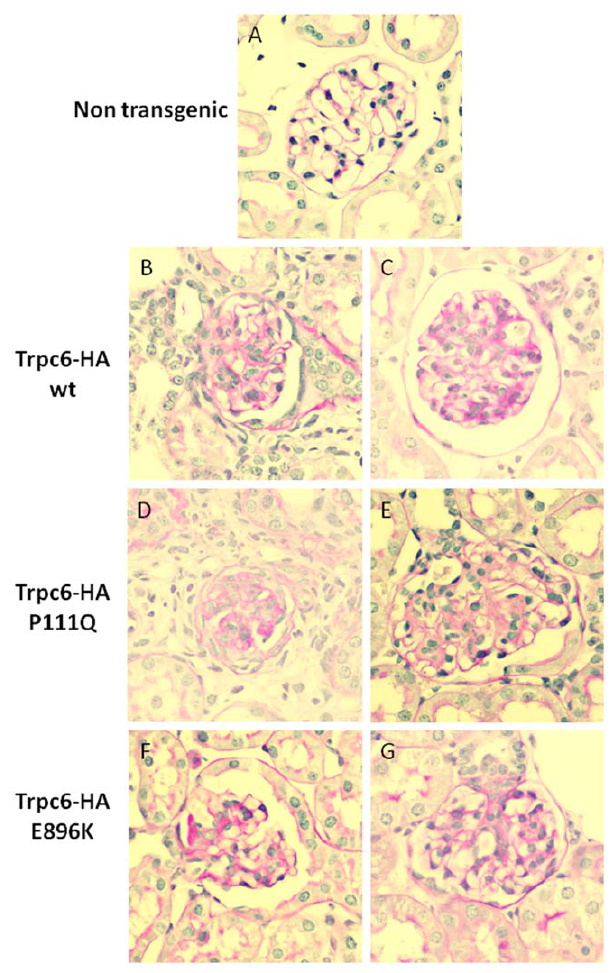
Figure 5. Histopathological lesions analyzed in adult trans- genic mice. Representative examples of kidney sections stained with PAS in 400x for all the samples are shown. (A) Non transgenic mouse normal glomerulus, (B) Trpc6-HA wt line 419, (C) Trpc6-HA wt line 421, (D) Trpc6-HA P111Q line 615, (E) Trpc6-HA P111Q line 616, (F) Trpc6-HA E896K line 73a and (G) Trpc6-HA E896K line 75a. The glomerular lesions were analyzed in blind by a pathologist and are summarized in Table 1.